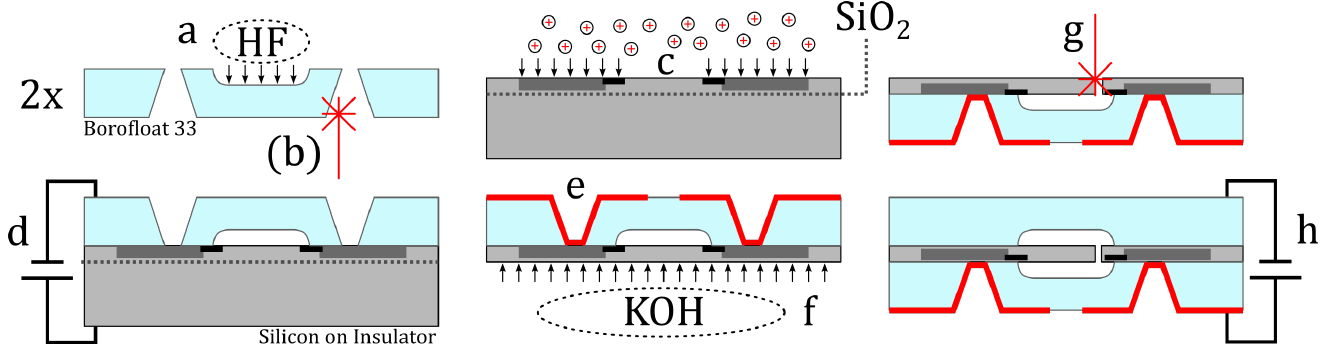
Figure 3. ( a ) Microscopic image of the chip surface after step (g) showing the femtosecond laser cuts in the silicon membrane and the Wheatstone bridge doping scheme. Dark gray areas marked by yellow frames indicate the highly-boron-doped silicon wiring; the four much smaller piezoresistive tracks with weaker doping are marked in red color. ( b ) MEMS vibrometers with 2mm × 2mm lateral dimensions and a thickness of 410µm. One is mounted onto polyimide PCB substrate by reflow soldering.